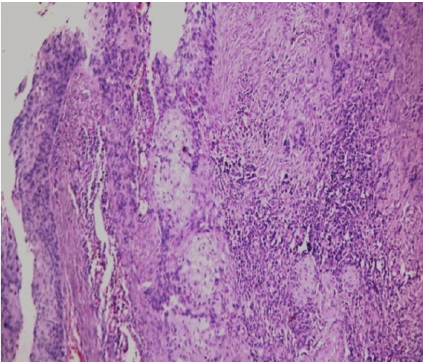
Figure 2: Islands of atypical squamous epithelium infiltrating underlying detrusor muscle with associated dense lymphocytic infiltrate (H&E stain, 100x).